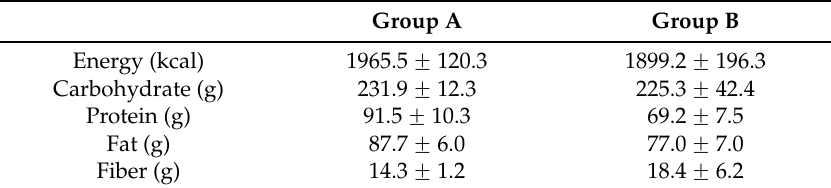
Table 1. Nutrient analysis of the two-day diet records of the participants (Mean ˘